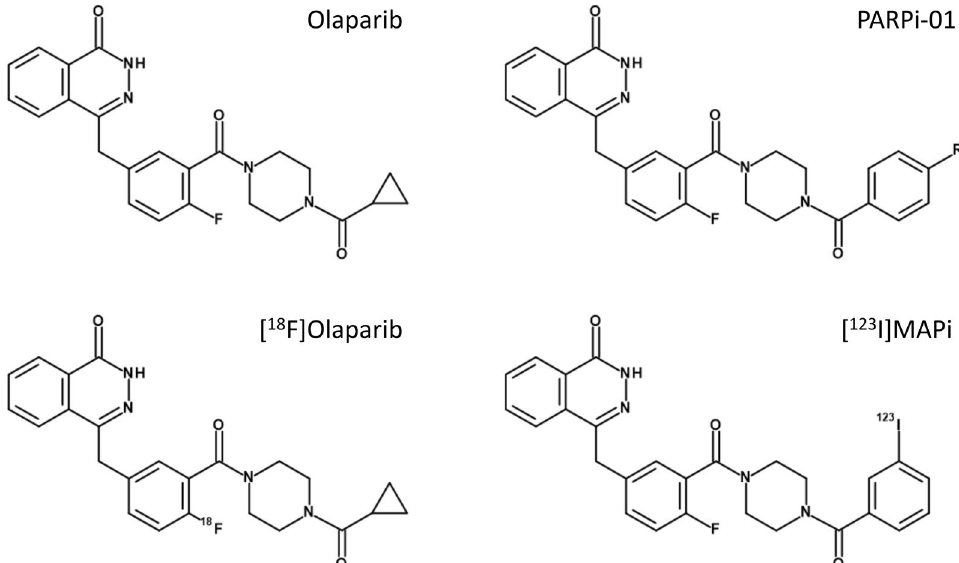
Fig. 1 Chemical structures of PARP inhibitor Olaparib and its derivatives. The structure of the compound used in this study is PARPi-01 (R 123/125 I. The labelling precursor used for the synthesis of [ 125 I]PARPi-01 has a R corresponding radiotracer has R = rucaparib derivatives please refer to